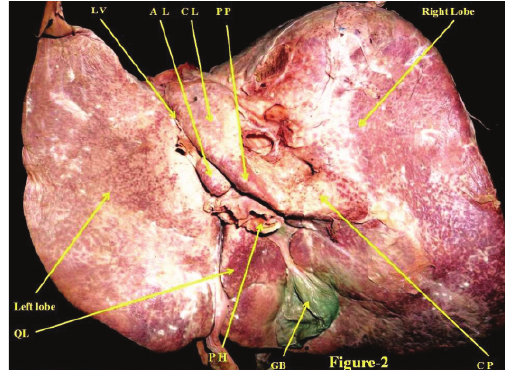
Figure2:Itshowsposteroinferiorviewofliver.CL:caudatelobeAL: accessory caudate lobe, PP: papillary process, CP: caudate process, QL: quadrate lobe, GB: gallbladder, LV: fissure for ligamentum venosum, PH: porta